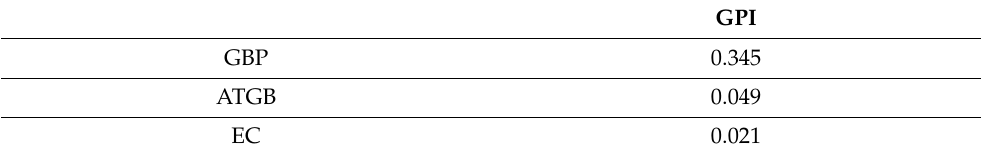
Table 8. Effect size ( f 2 ).